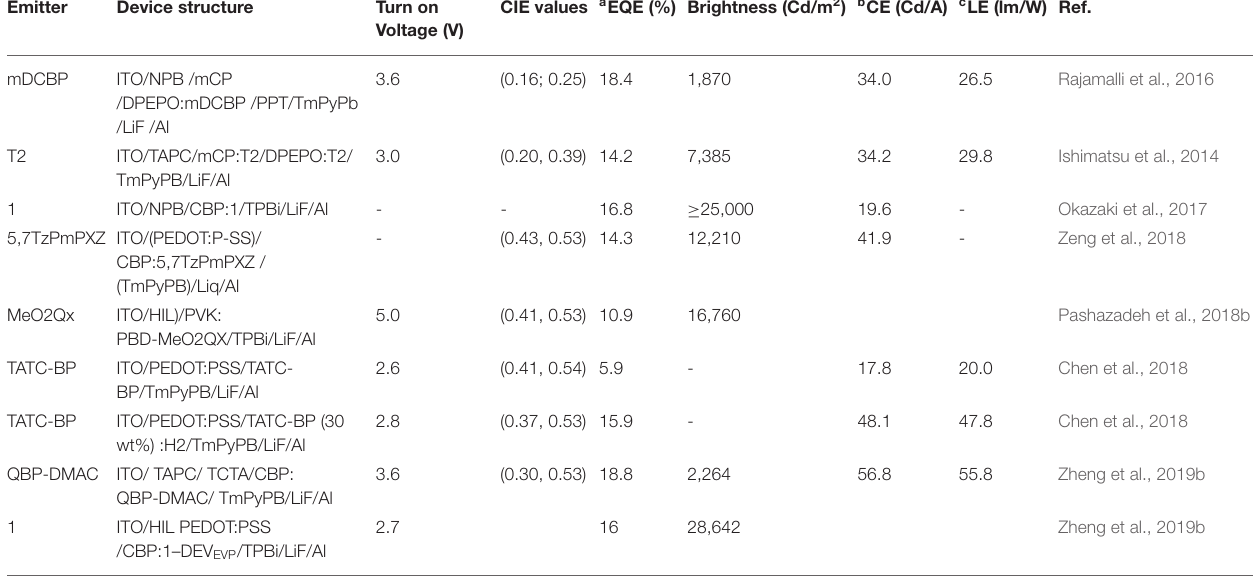
TABLE 2 | TADF-OLED device configurations and related EL-device